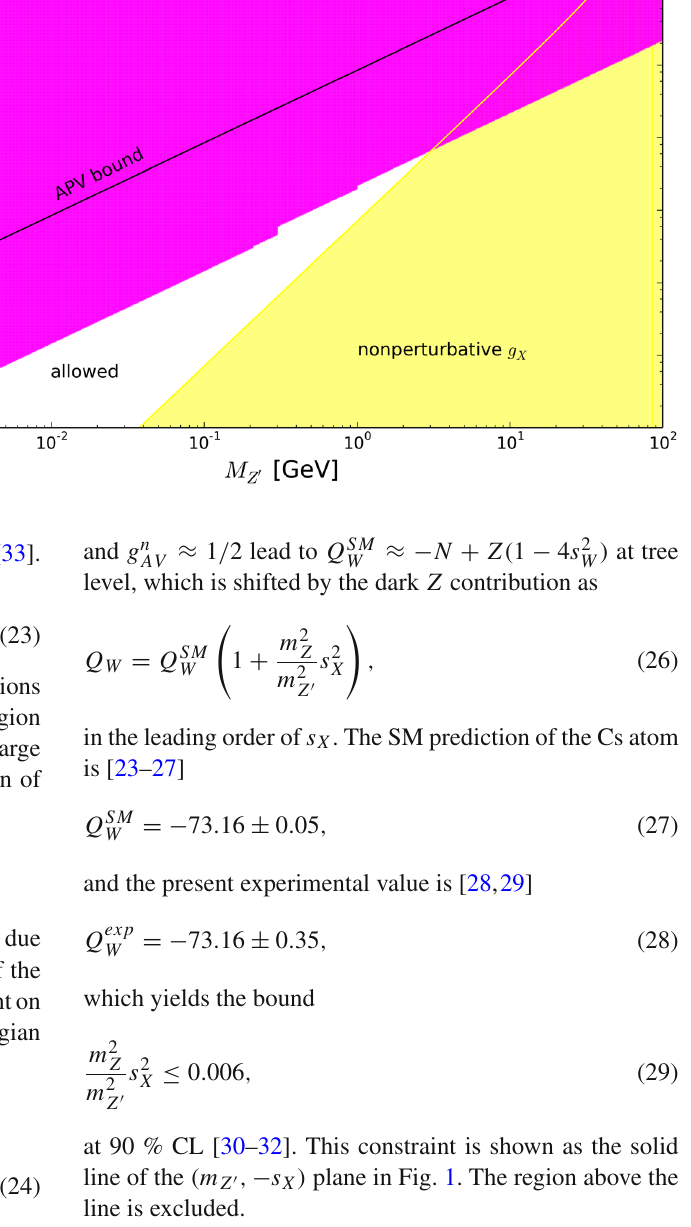
Fig. 1 Excluded regions in ( M , − s ) plane. The green X Z (cid:2) (light grey) region is excluded by too small (cid:12)ρ and the blue (dark grey) region excluded by too large (cid:12)ρ . The pink (grey) region shows exclusions by rare K and B decays. The solid line denotes the atomic parity violation bound and the region above the line is excluded. The yellow region is disfavoured by the nonperturbative U(1) X gauge coupling, g X > 4 π . The allowed points of ( M Z (cid:2) , − s X ) fall on the white triangular